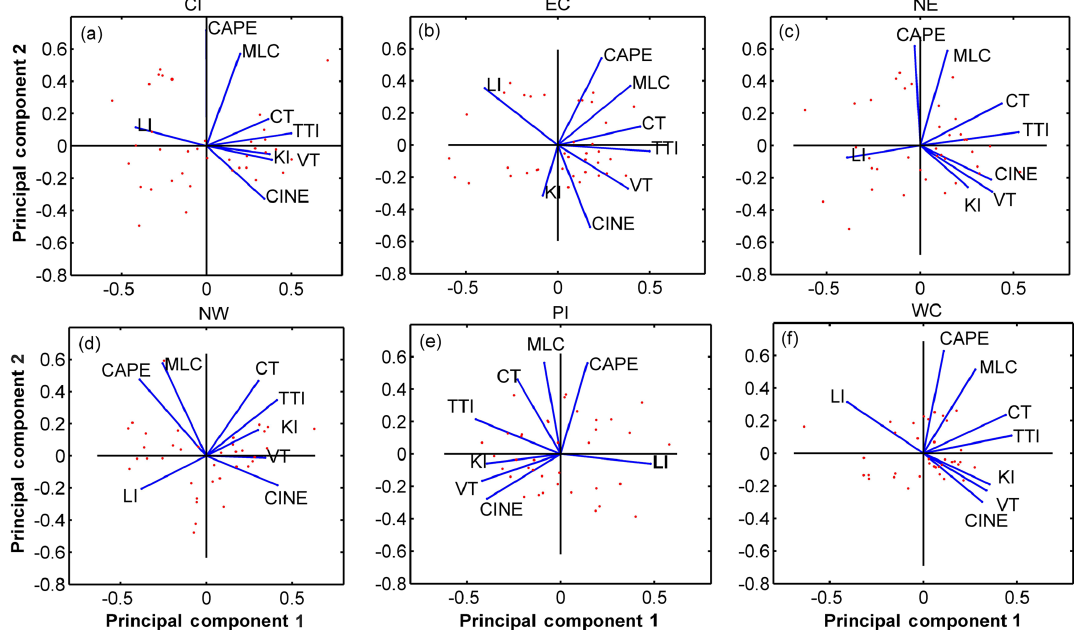
Figure 2. Principle component analysis (PCA) for the selection of instability parameters for the long-term trend study in (a) Central India (CI), (b) East Coast (EC), (c) , North East (NE), (d) North West (NW), (e) Peninsular India (PI), and (f) West Coast (WC) obtained using IGRA